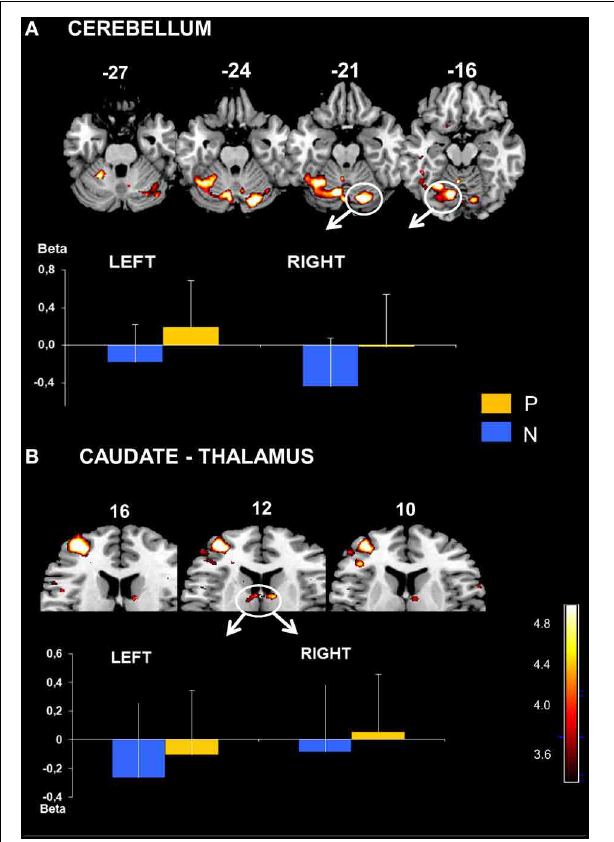
FIGURE 5 | (A) Cerebellar activation obtained with P > N contrast. Bilateral activation in cerebellum displayed on the template axial sections. The graph represents mean beta values extracted at the maximal peak of activation during No-Pause (N) and Pause sequences (P) in right and left cerebellum clusters (indicated in the Figure). P corrected < 0.01. Bars = standard deviations. Caudate and Thalamic activation. (B) Bilateral activation in caudate nucleus displayed on template axial sections. The graph represents mean beta values extracted at the maximal peak of activation during No-Pause (N) and Pause sequences (P) in right and left caudate clusters. P corrected < 0.05. Bars = standard deviations.